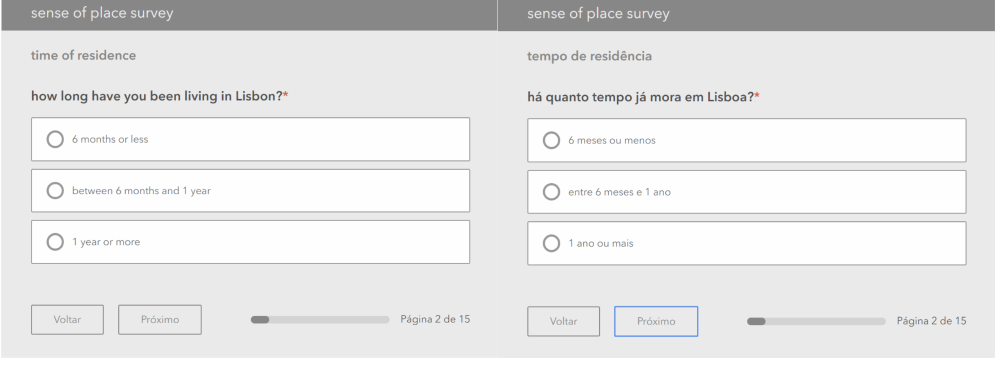
Figure 4: Time of residence question.